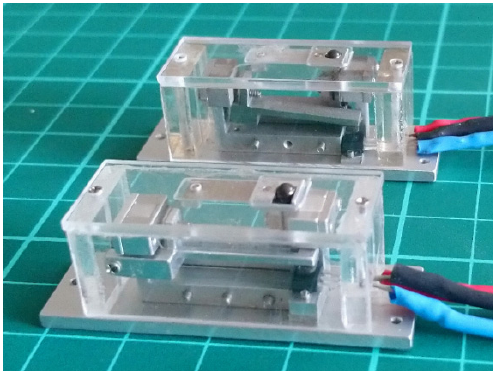
Figure 31. The completed LCMDS Alpha Model, in side view.